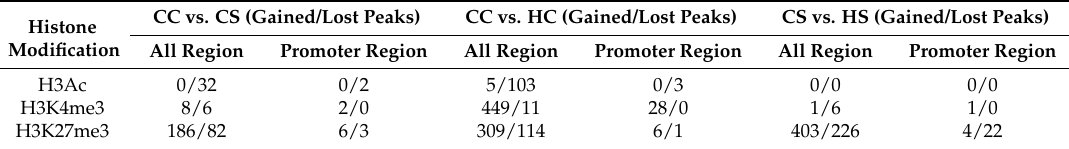
Table 1. Genome-wide, differential binding of enriched histone modification peaks.